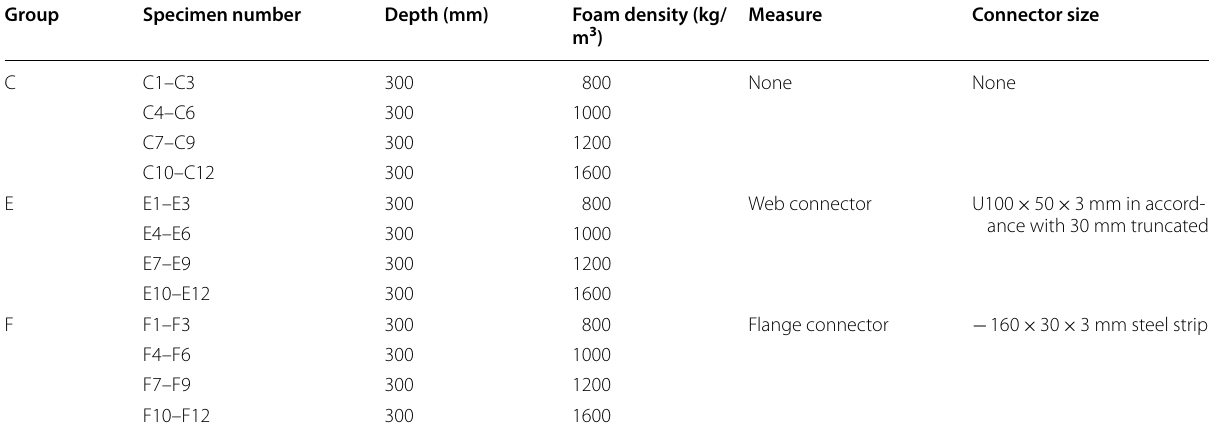
Table 1 Configuration of test specimens.